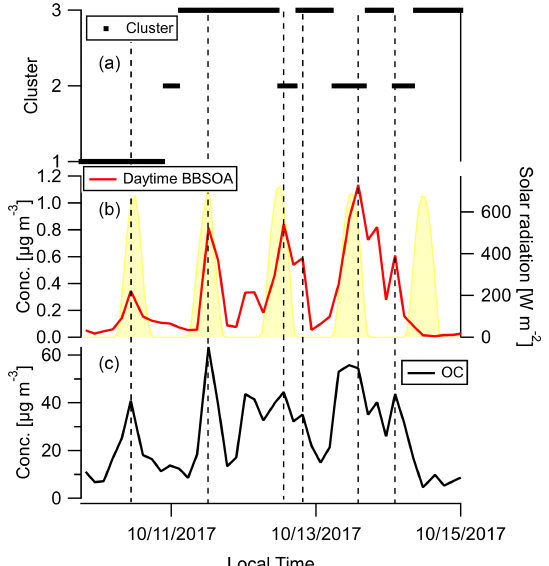
Figure 9. Time series of (a) backward trajectory clusters (b) , con- centration of compounds in the daytime BB SOA factor, and (c) OC. Solar radiation in panel (b) was measured at Bethel Island, a mea- surement site in between Napa and Berkeley. The vertical reference lines mark peaks of fire plumes. Dates are indicated in mm/dd/yyyy format.